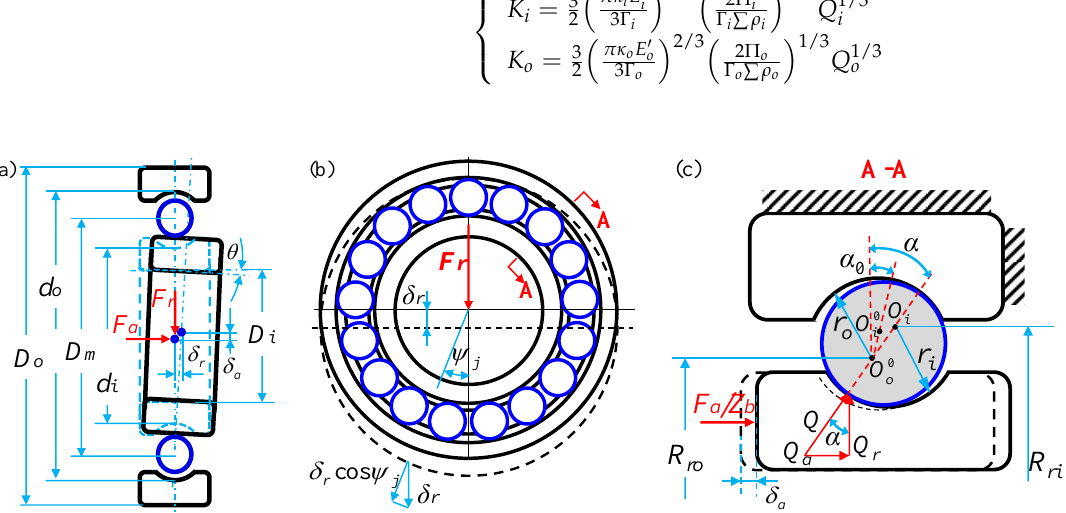
Figure 2. Geometric deformation of a deep groove ball bearing under different loads: ( a ) axial load, ( b ) radial load, and ( c ) torque load.